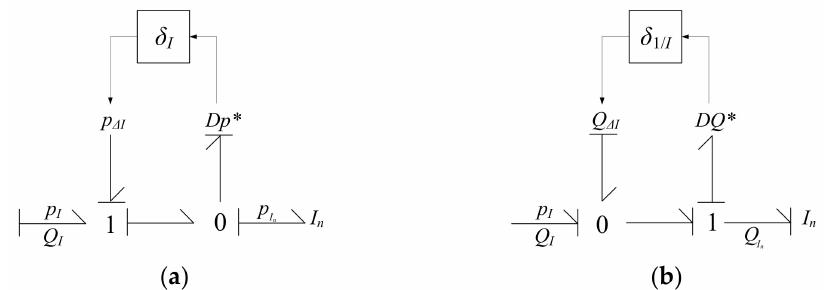
Figure 10. BG-LFT model of inertial element: ( a ) integral type; ( b ) differential type.